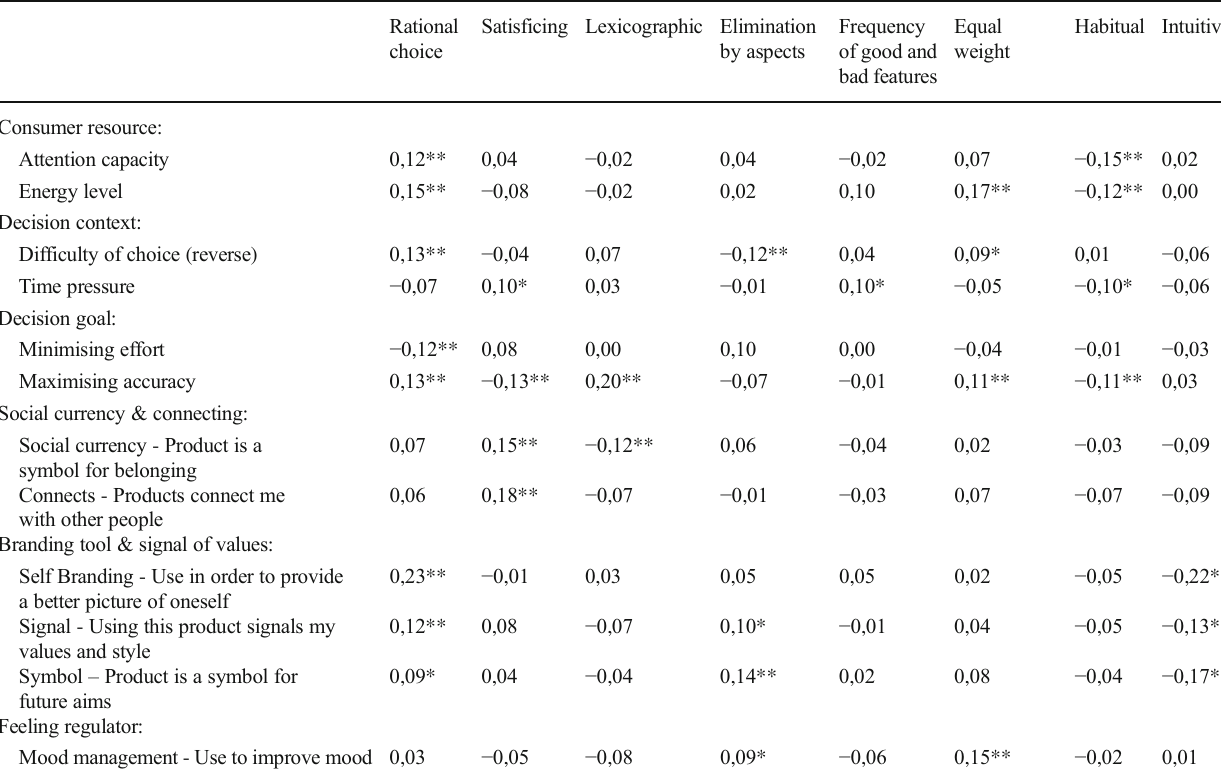
Correlation dataof decision-making context, consumer resources, psychological drivers of consumption and decision-making strategiesbased on data in Willman-Iivarinen (2018) Rational Satisficing Lexicographic Elimination choice by